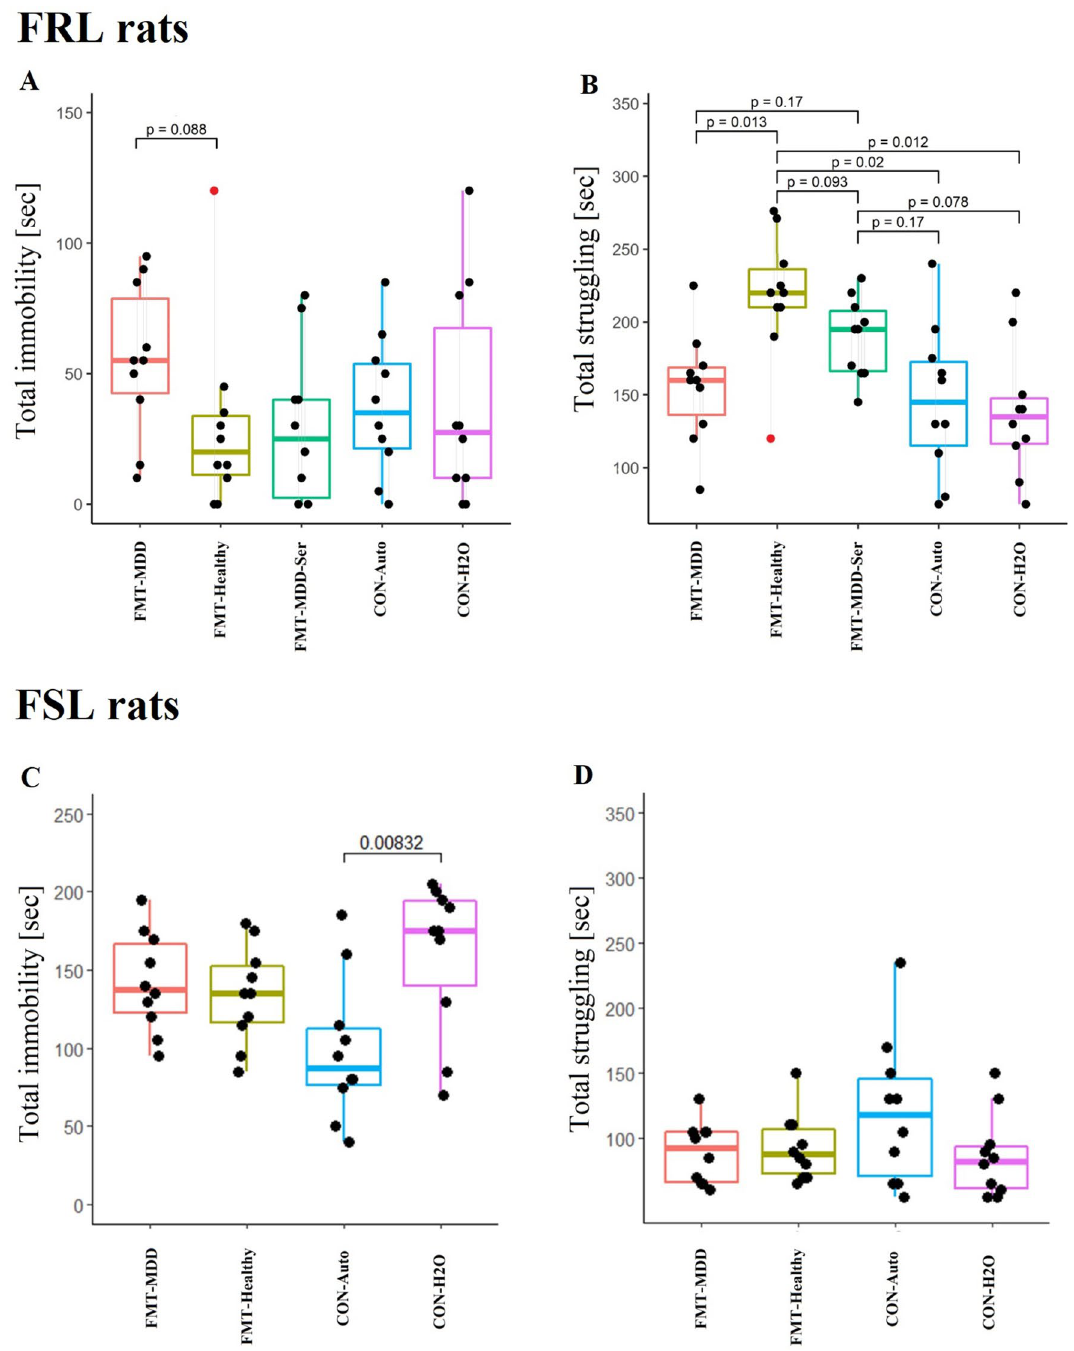
Figure 1. Behavioural analysis of the forced swim test of FSL and FRL rats. Total immobility time (sec) ( A , C ) and total struggling time (sec) ( B , D ) of rats from each group of FRL ( A , B ) or FSL ( C , D ) rats based on recordings of the first 5 min. P -values were included in the figure if they were below 0.2. Grey lines represent cohoused animals in the FRL group. The red dot represents the rat that was removed from the analysis as mentioned in the Methods section. FMT-MDD: Faecal microbiota transplantation from patients with MDD into rats. FMT-Healthy: Faecal microbiota transplantation from healthy individuals into rats. FMT-MDD-Ser: Faecal microbiota transplantation from patients with MDD into rats combined with treatment with sertraline. CON-Auto: Rats receiving auto-transplantations. CON-H2O: Rats receiving demineralised